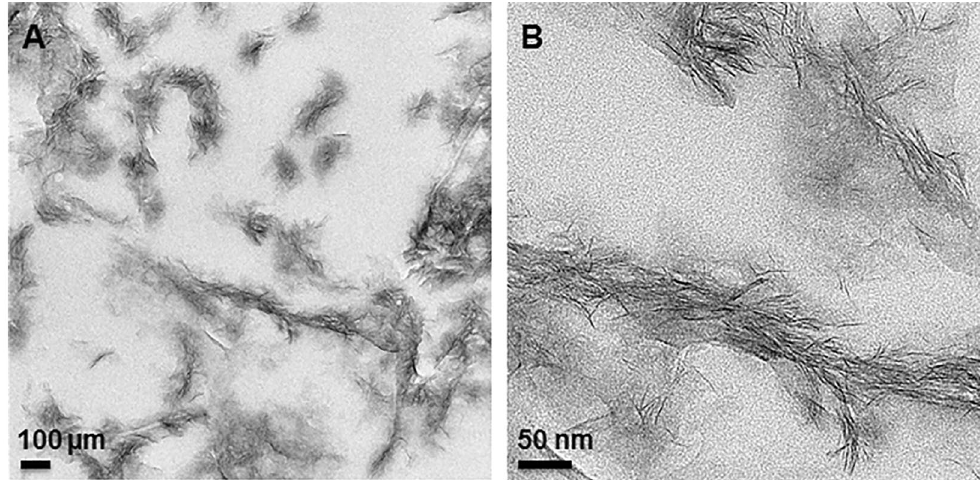
Figure 4. TEM images of ultrathin sections of synthesized sauconite with 1.0 M succinate at pH 0 9.0 after 20 h at 90 °C. ( A ) Overview of the area in the section containing aggregates of sauconite crystals. ( B ) Close-up of an aggregate of sauconite in the center of ( A ) showing the disorganized arrangement of individual 2:1 layer silicates with the occasional short-range stack of coherent layers.